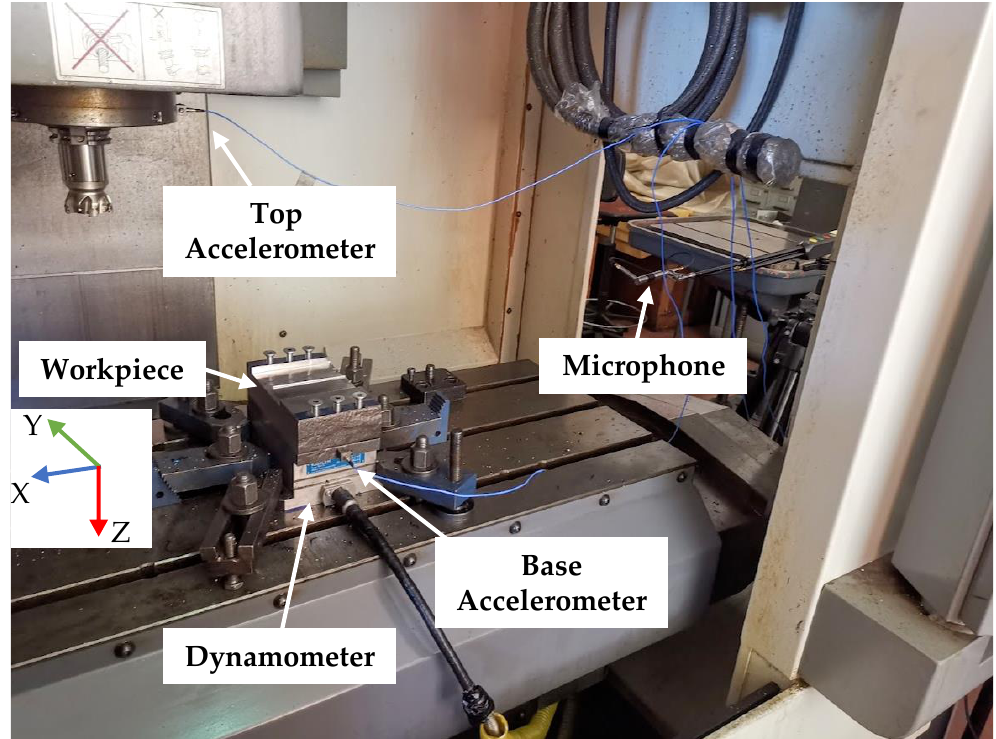
Figure 6. Experimental setup for Experiment